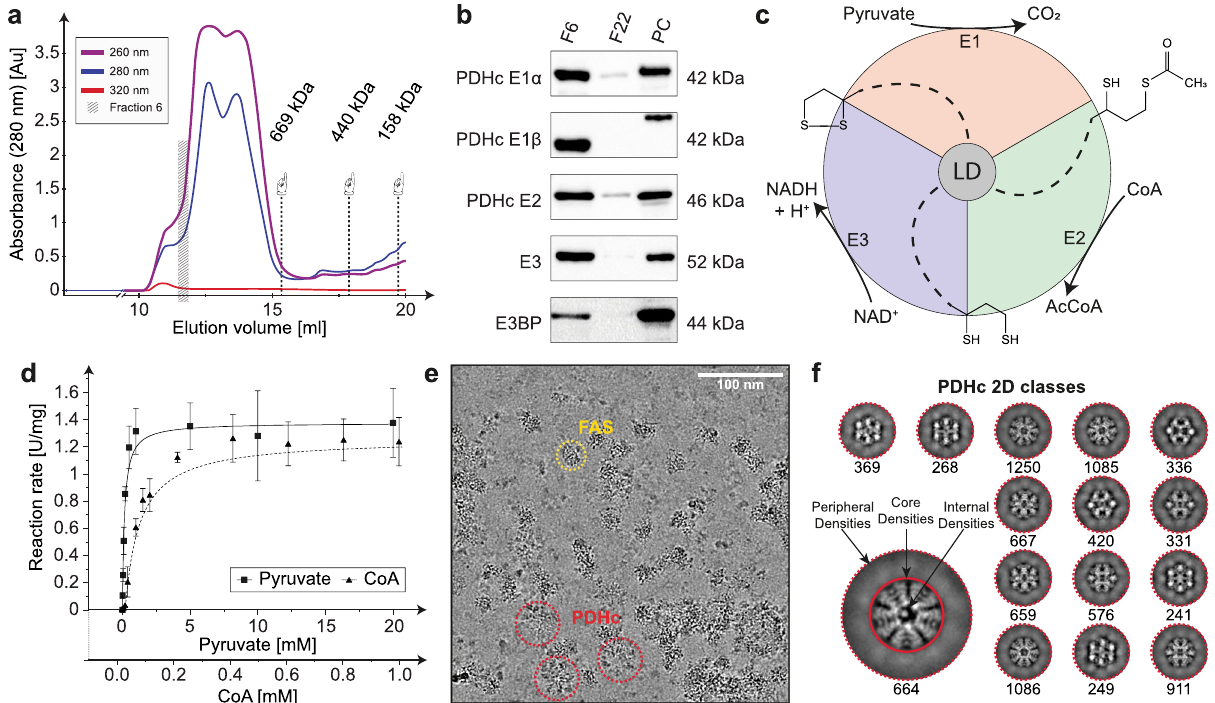
Fig. 1 Biochemical characterization of the native pyruvate dehydrogenase metabolon. a Size-exclusion chromatography (SEC) pro fi le of C. thermophilum cell extract. Fraction 6, corresponding to ~10 MDa complexes, further analyzed in this study, is highlighted. The retention volume of high-molecular-weight standard proteins are shown and includes thyroglobulin (669 kDa), ferritin (440 kDa), and aldolase (158 kDa). b Detection of all components of the PDHc metabolon ( n = 1). Fraction 6 (F6), Fraction 22 (F22; negative control), and recombinant protein, used for antibody production (PC positive control) were analyzed. The displayed molecular weight corresponds to the recombinant protein. c Reaction pathway during pyruvate oxidation. The reaction is mediated by the lipoate (shown as skeletal structural formula) covalently bound to the LD. The reaction requires three distinct active sites at E1, E2, and E3 of PDHc to occur. d Enzymatic characterization of native PDHc. Pyruvate and CoA were used in the shown concentration range and the reaction rate was fi tted with a hyperbolic function following Michaelis – Menten kinetics. Center of error bars correspond to the mean value, error bars correspond to standard deviation derived from n = 3 independent biological samples (technical duplicates in each). e Representative micrograph of F6 after denoising. PDHc in higher-order assemblies is visible in a heterogeneous environment, e.g., including fatty acid synthase molecules (FAS). f 2D classes of PDHc retrieved from cryo-EM single-particles. External, core, and internal densities are clearly distinguishable. Numbers below representative class averages correspond to the number of particles included in each